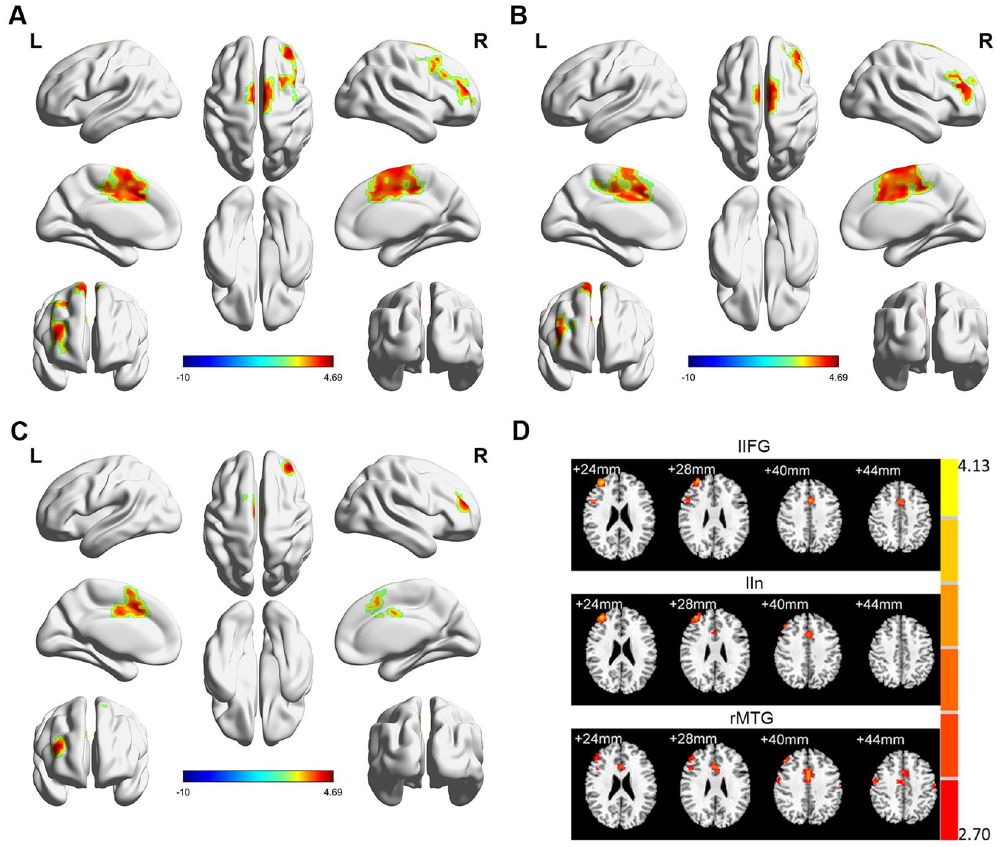
Figure 3. Functional connections altered in the resting state. Based on using the ( A ) lIFG, ( B ) lIn and ( C ) rMTG as seeds, the functional connectivity was enhanced in the PE patients compared with the NC group. An independent sample t-test was applied between the two groups (T maps threshold at p < 0.05, AlphaSim corrected). ( D ) The brain areas where functional connectivity was enhanced in the left inferior frontal gyrus and left insula. rMTG: right middle temporal gyrus; lIFG: left inferior frontal gyrus; lIn: left